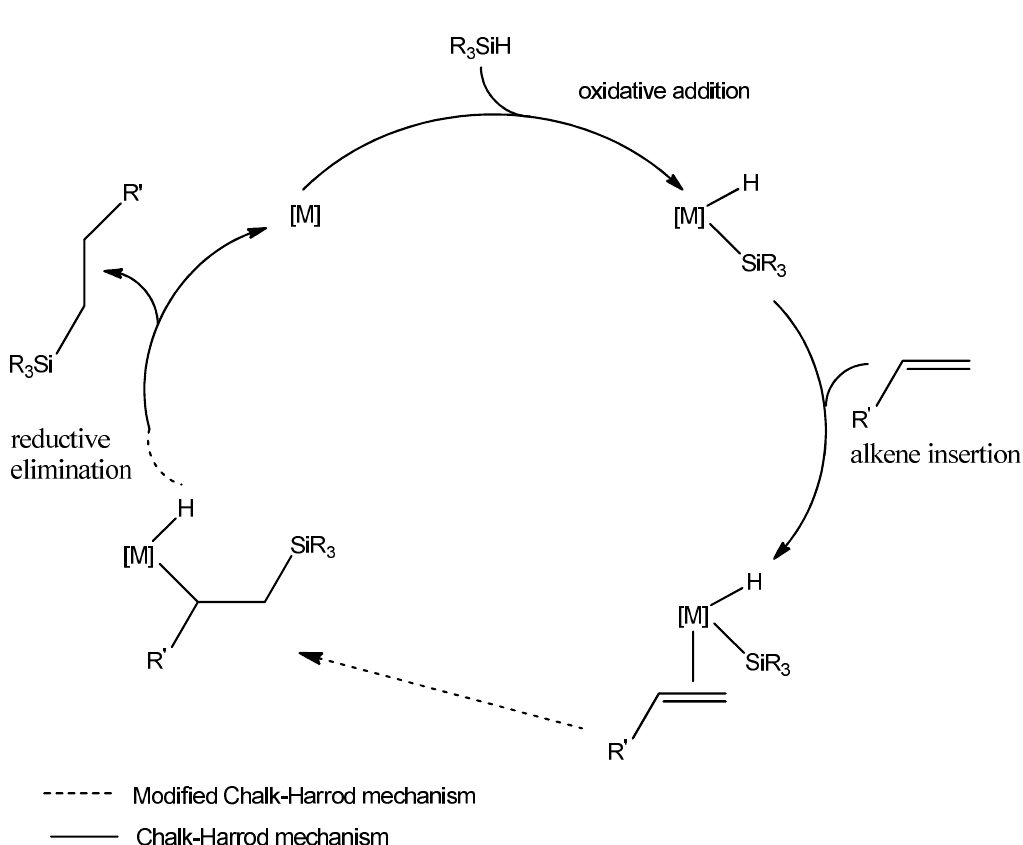
Figure 9. Hydrosilylation mechanism and modified mechanism proposed by Chalk and Harrod [63].